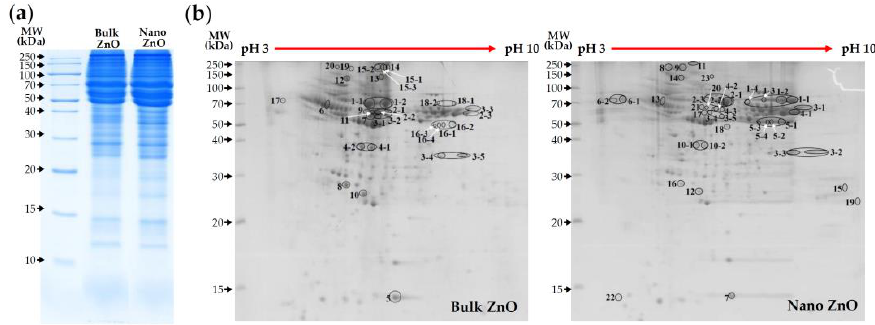
Figure 5. Plasma protein-binding profiles of bulk and nano ZnOs separated by ( a ) one-dimensional and ( b ) two-dimensional gel electrophoresis.